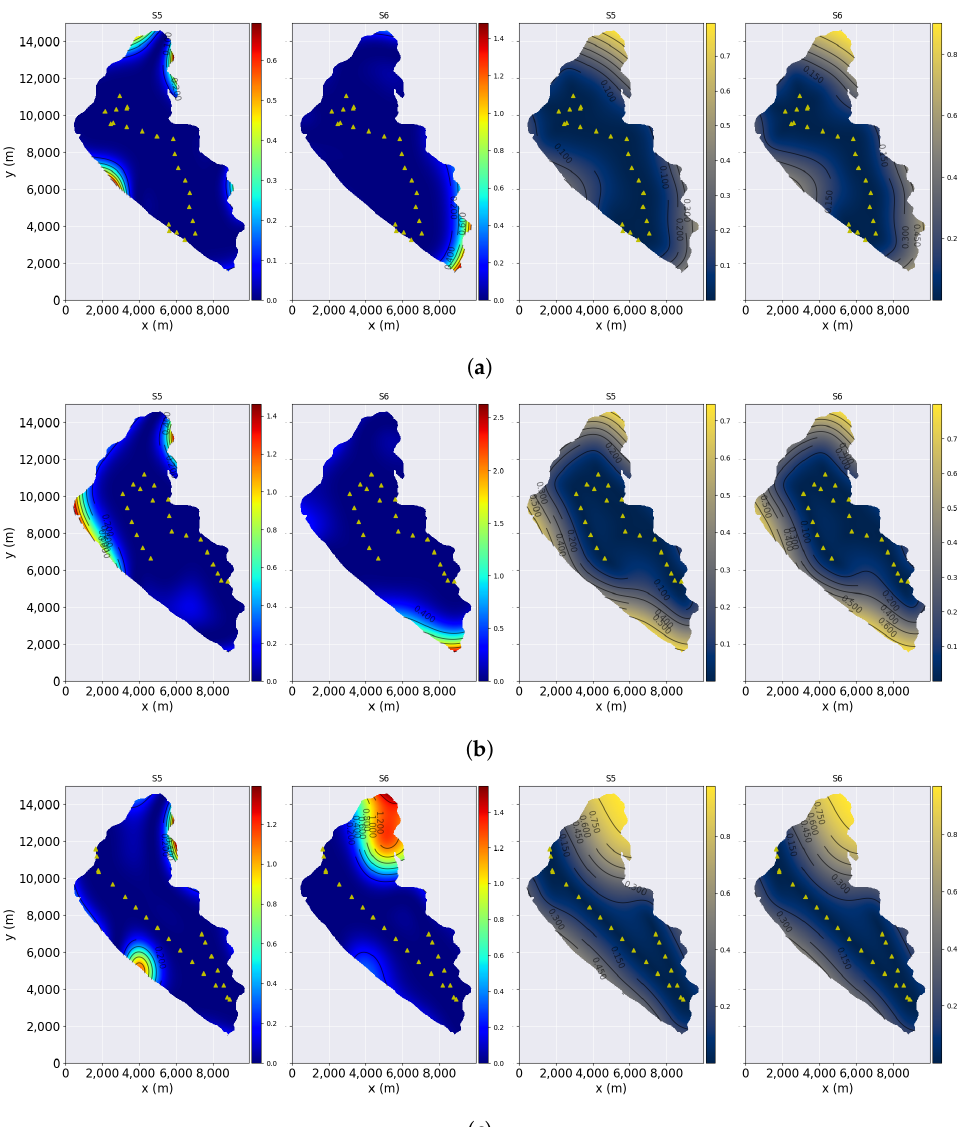
Figure 9. Best results for each method when the ASV measures two different parameters. ( a ) Squared error and uncertainty maps for the proposed MEBO approach. ( b ) Squared error and uncertainty maps for the PESMOC approach. ( c ) Squared error and uncertainty maps for GA